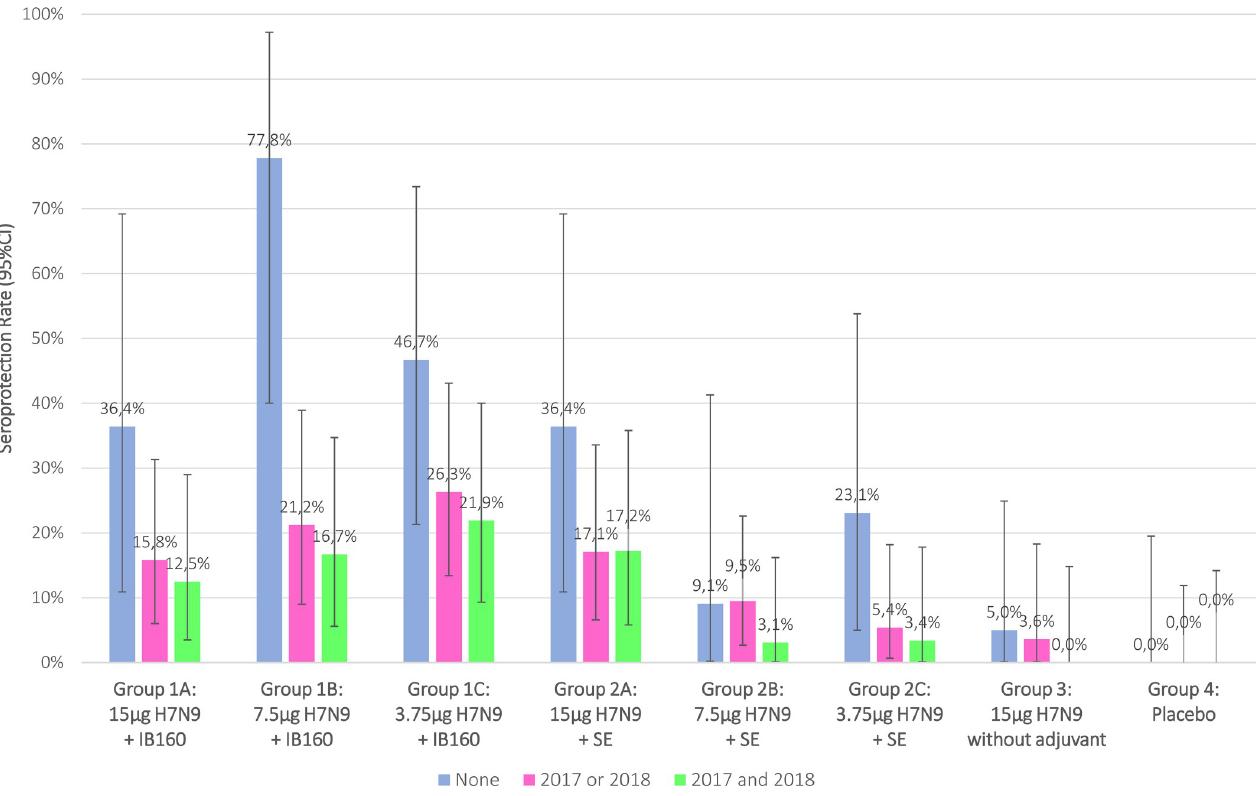
Fig 3. HI antibody against H7N9 reverse cumulative distribution curve after 28(+7) days post 2nd dose administration, per protocol analysis.